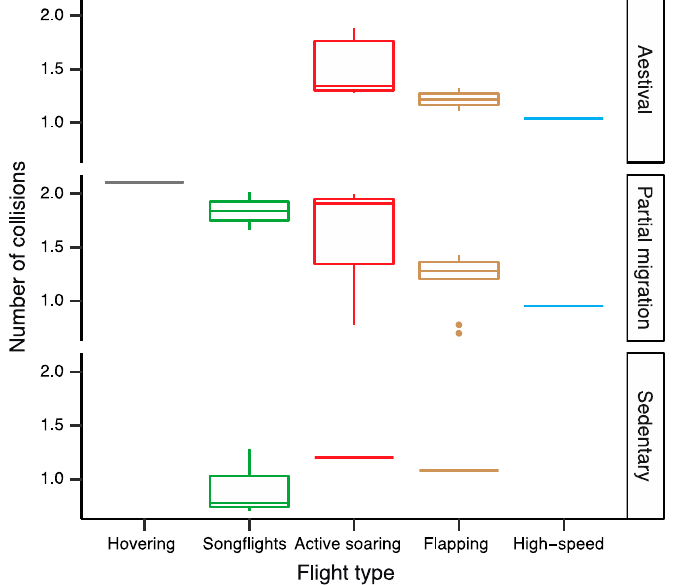
Figure 3. Graph showing the boxplots for the two-way ANOVA assessing the number of collisions (log10) for species depending on flight types and movements.